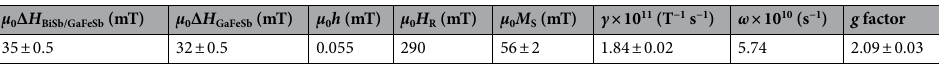
Table 2. Parameters obtained by fitting our model to the experimental FMR spectra. Δ H BiSb/GaFeSb and Δ H GaFeSb are the FMR spectral linewidths for sample A and sample B when magnetic field H // [ 110 ] , respectively; μ 0 h, μ 0 H R , ω , and g are the microwave magnetic field, resonance field, angular microwave frequency, and g factor, respectively. γ = gμ B /ℏ is the gyromagnetic ratio and μ 0 M S is the saturation magnetization measured by SQUID.